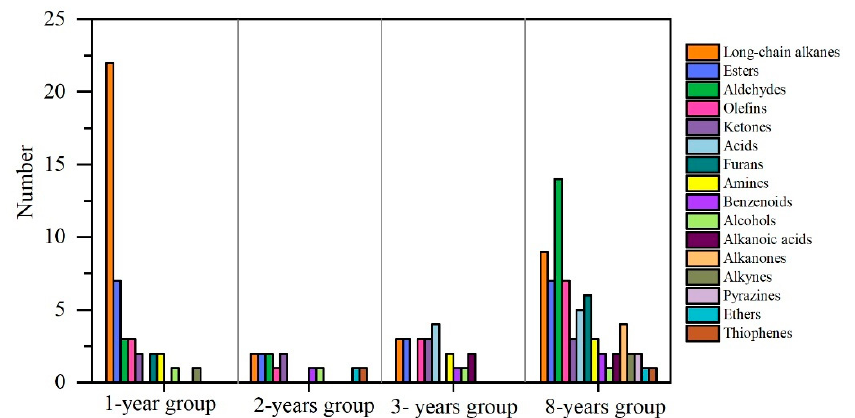
Figure 4. The classification and amount of VOCs in shrimp paste samples fermented for 1, 2, 3, and 8 years.